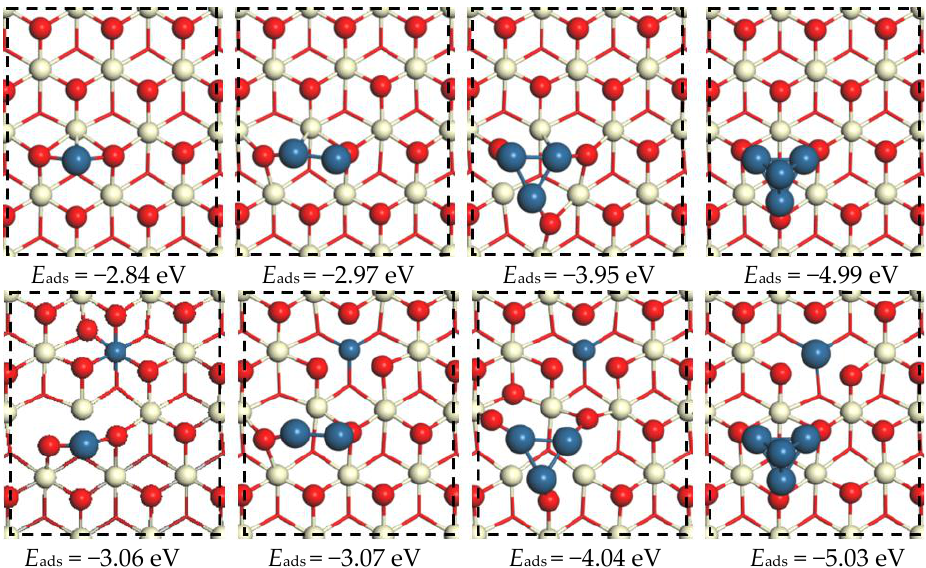
Figure 1. Top views of the optimized configurations of the support surface: ( a ) CeO 2 (111), ( b ) (Pt − Ce)O 2 _I, and ( c ) (Pt − Ce)O 2 _II. The inset in ( b ) and ( c ) show the detailed configuration of the doped Pt. Ce (pale yellow), O (red), and Pt (cyan).